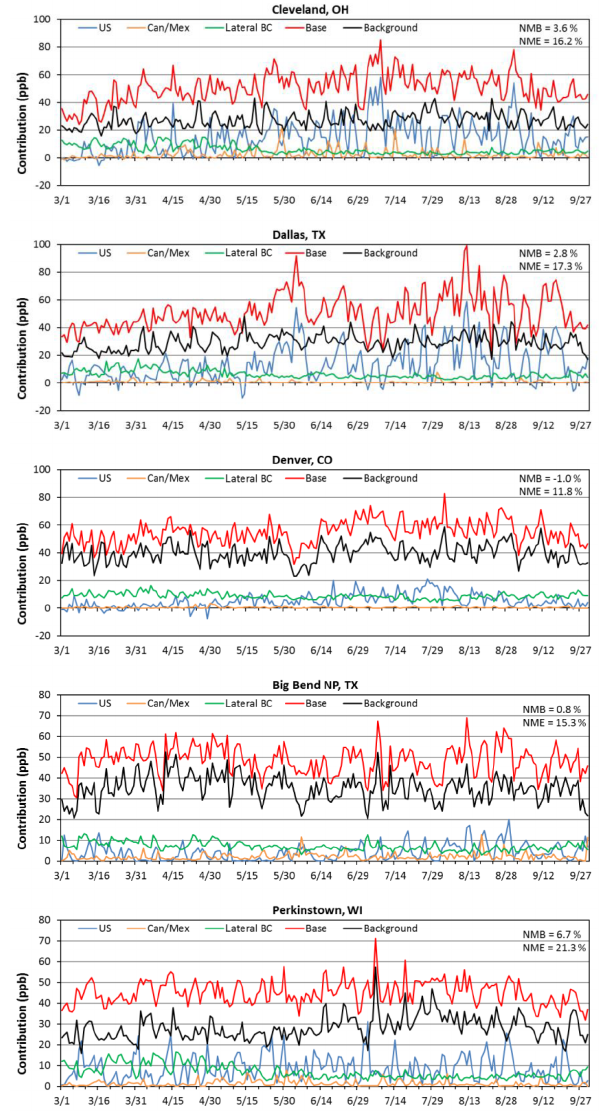
Figure 11. Anthropogenic contributions to MDA8 O 3 at selected AQS and CASTNet sites along with base-case and background con- centrations and model performance statistics (no